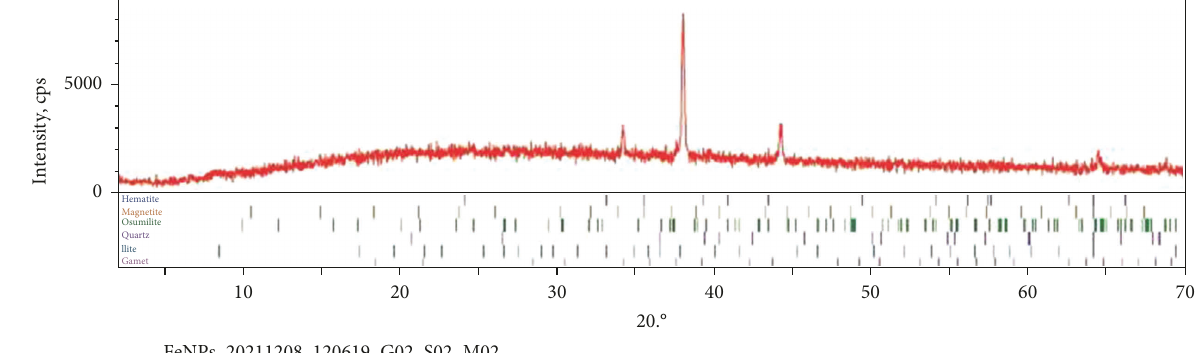
Figure 1: X-ray diffraction spectrum of iron oxide nanoparticles.